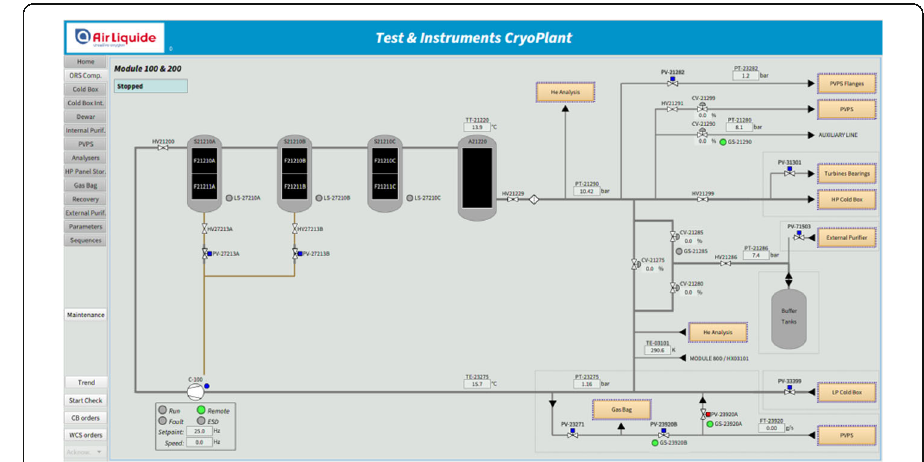
Fig. 6 Original operator screen in TICP by Air